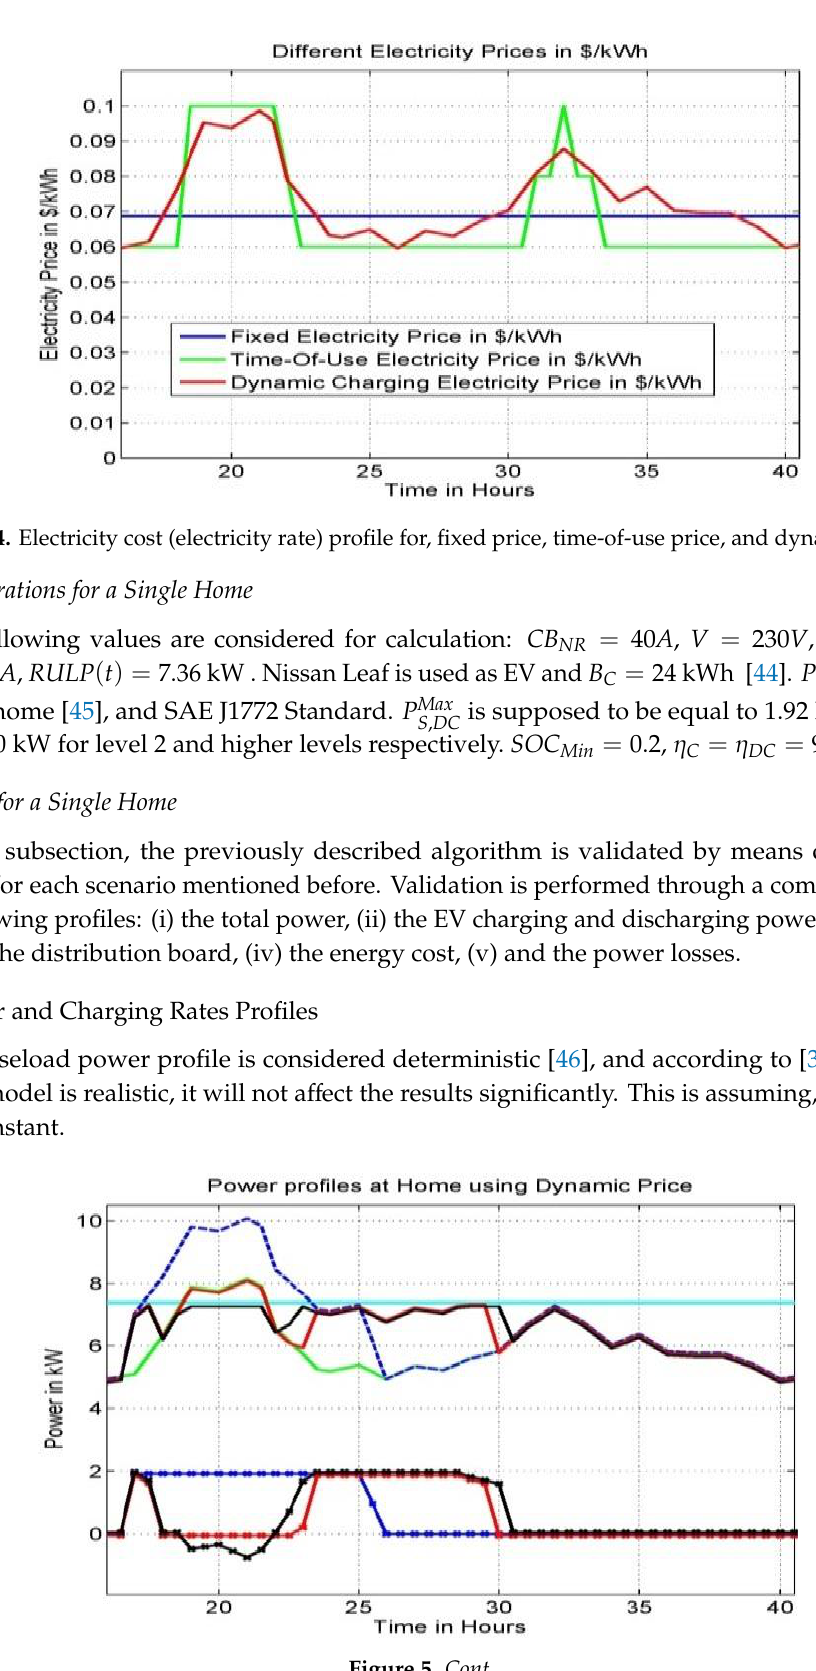
Figure 5. Power profiles and charging rate profiles at home. Figure 6. Voltage profiles at home.